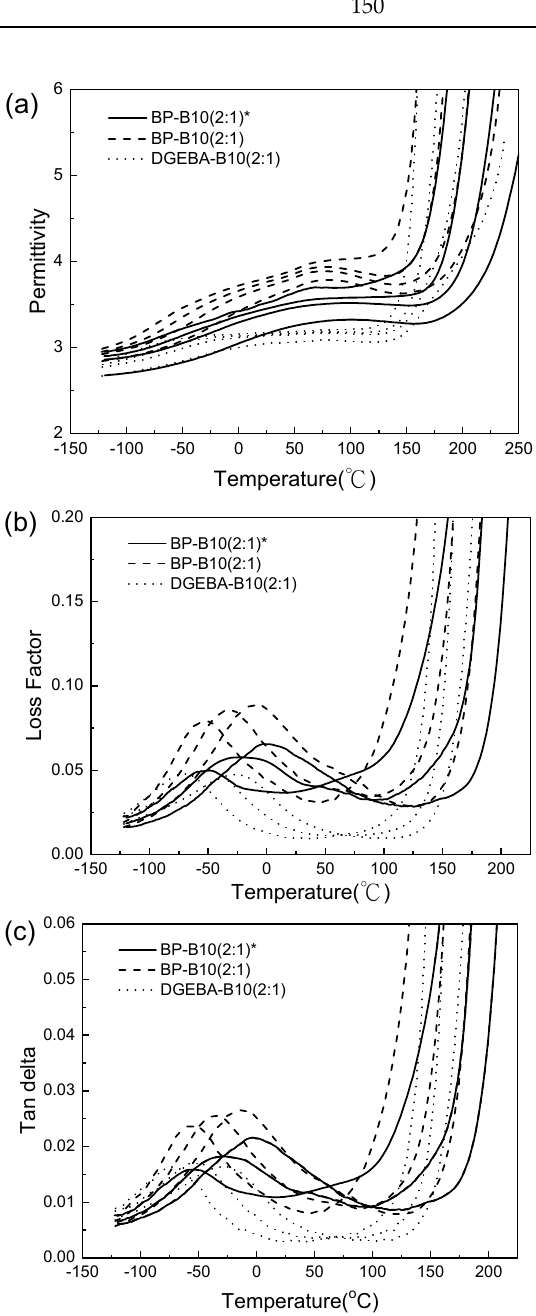
Figure 7. ( a ) Permittivity, ( b ) loss factor and ( c ) tan delta of cyanate ester (B10)-cured epoxy at 100, 1000 and 10,000 Hz (curves from left to right) (*: